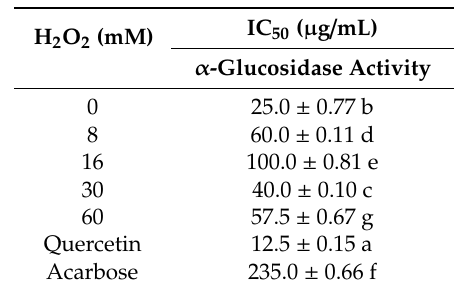
Table 3. E ff ect of H 2 O 2 on α -glucosidase activity (IC 50 mg / mL) of Ficus deltoidea var deltoidea leaf. Means (S.E.) with same letter do not di ff er significantly according to the She ff er’s post hoc test at α = 0.05.